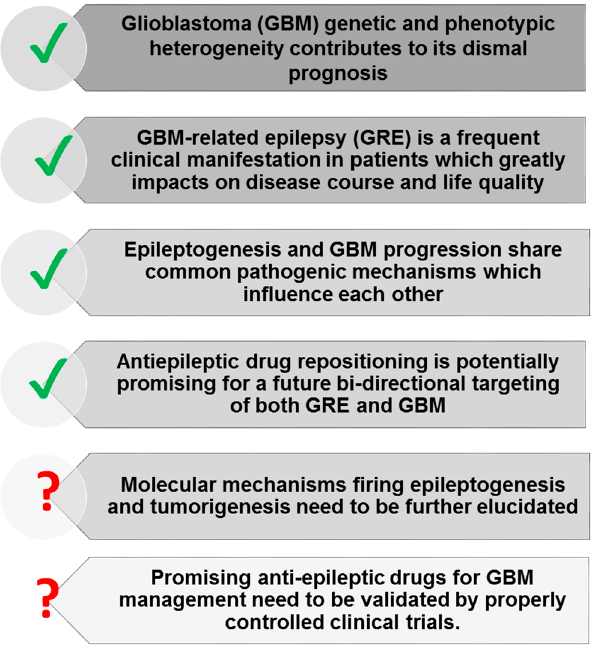
Figure 3. Antiepileptic drugs in human glioblastoma—a quick overview of current knowledge and future perspectives.